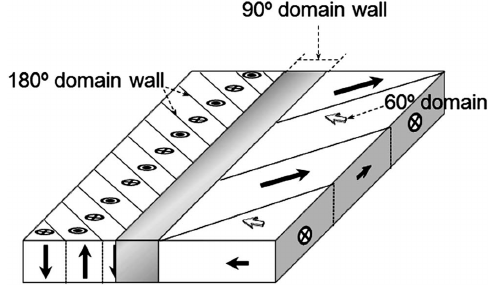
Figure 13. Schematic representation of the three-dimensional domain structure. Adapted from [59], with permission from © 2012 Royal Society of Chemistry.